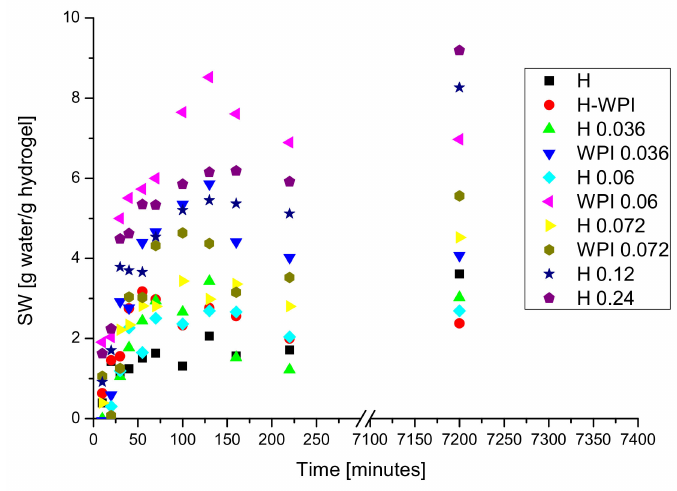
Figure 5. The variation of the swelling degree as a function of swelling time.